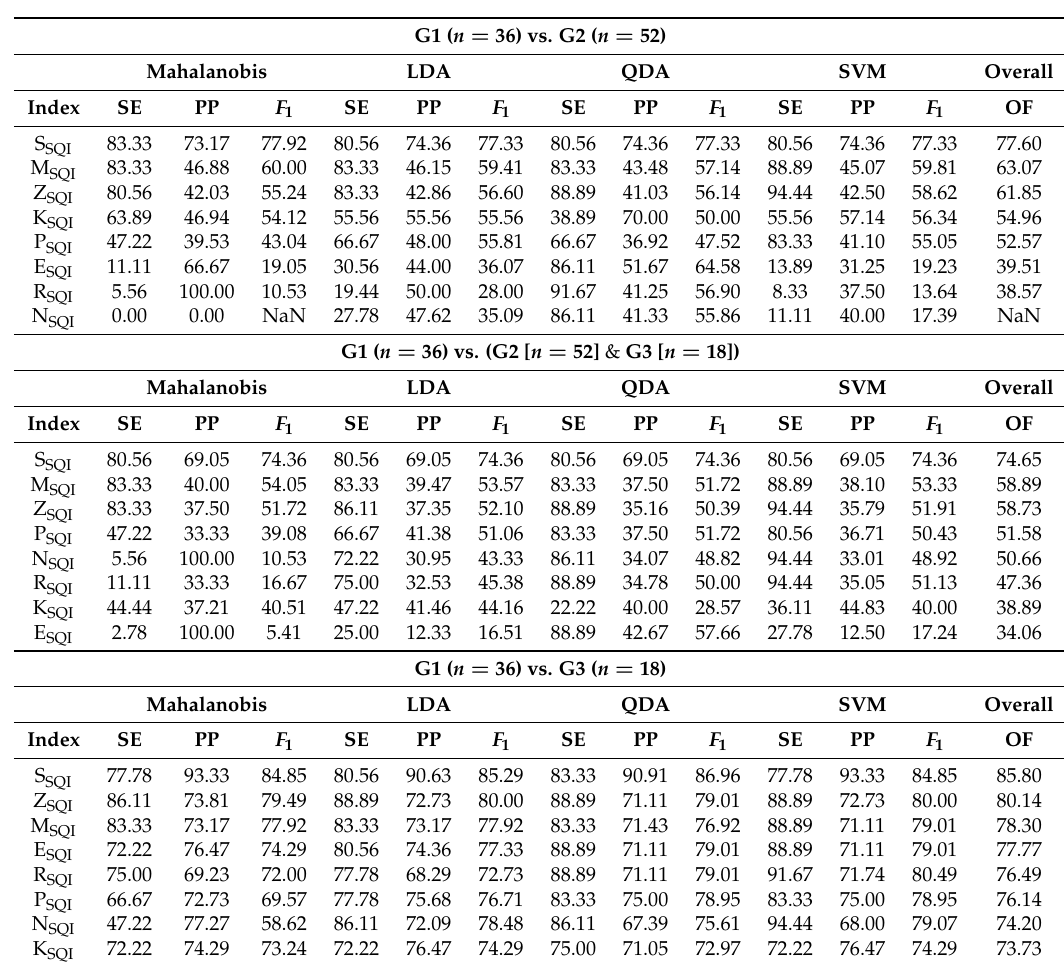
Table 3. Leave-one-out classification rate of the signal quality indices ranked in descending order. Four classification methods are used in this analysis: Mahalanobis distance, linear discriminant analysis (LDA), quadratic discriminant analysis (QDA), and the linear support vector machine (SVM). Eight SQIs are tested: perfusion (P SQI ), kurtosis (K SQI ), skewness (S SQI ), relative power (R SQI ), non-stationarity (N SQI ), zero crossing (Z SQI ), entropy (E SQI ), and the matching of systolic wave detectors (M SQI ). The F 1 value of discriminating between excellent signal quality (G1), acceptable signal quality (G2), and unfit to diagnose signals (G3) is given in the last column of each comparison. Here, SE stands for sensitivity, PP stands for positive predictivity, F 1 stands for F 1 score accuracy test, OF stands for overall F 1 of all classifiers (average of all F 1 ), and NaN stands for not a